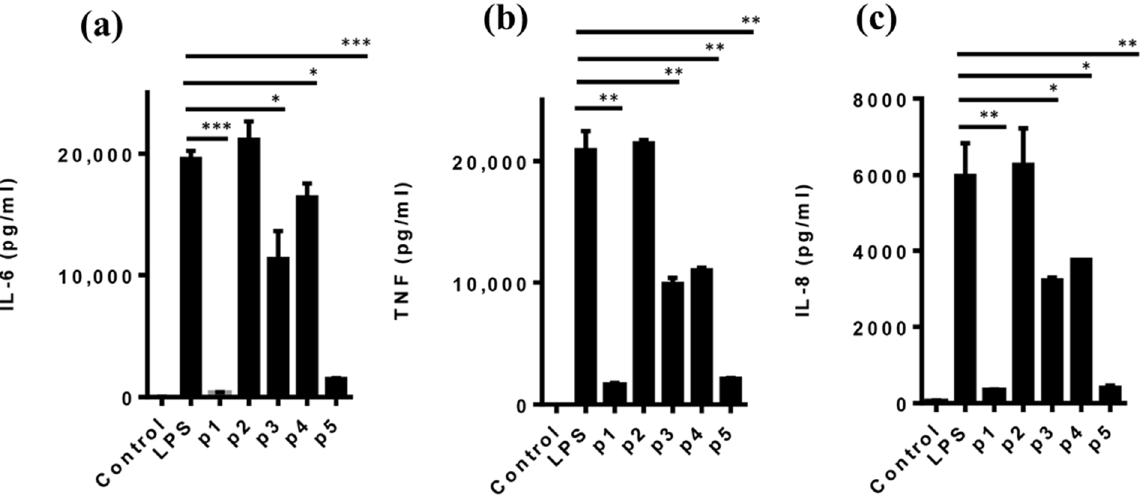
Figure 3. Effect of peptides on LPS-activated monocyte-derived macrophages. Cells were treated with 1 mM of each of the peptides DIKTNKPVIF (p1), DIKTNKPVI (p2), TNKPVIF (p3), DIK (p4) and TNKPVI (p5) for 1 h before activation with LPS to induce inflammation. The levels of pro-inflammatory cytokines ( a ) interleukin (IL)-6, ( b ) tumor necrosis factor (TNF) and ( c ) IL-8 in the culture supernatant were determined by ELISA. Values are mean ± S.D. * p < 0.05, ** p < 0.01, *** p < 0.001 vs. LPS.